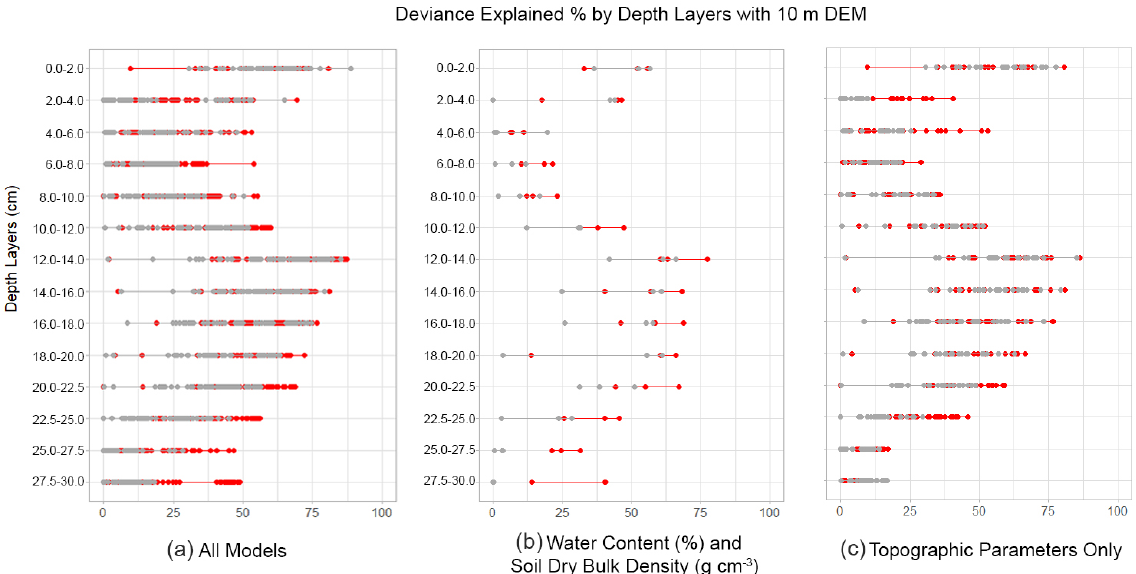
Figure 11. Deviance-explained percentages using the 10m DEM. (a) All parameter combinations soil properties and topographic parameters. (b) Parameter combinations with only water content (%) and soil dry bulk density (gcm − 3 ; the same graphic in Fig. 10 is repeated for the comparison purpose). (c) Parameter combinations with only topographic